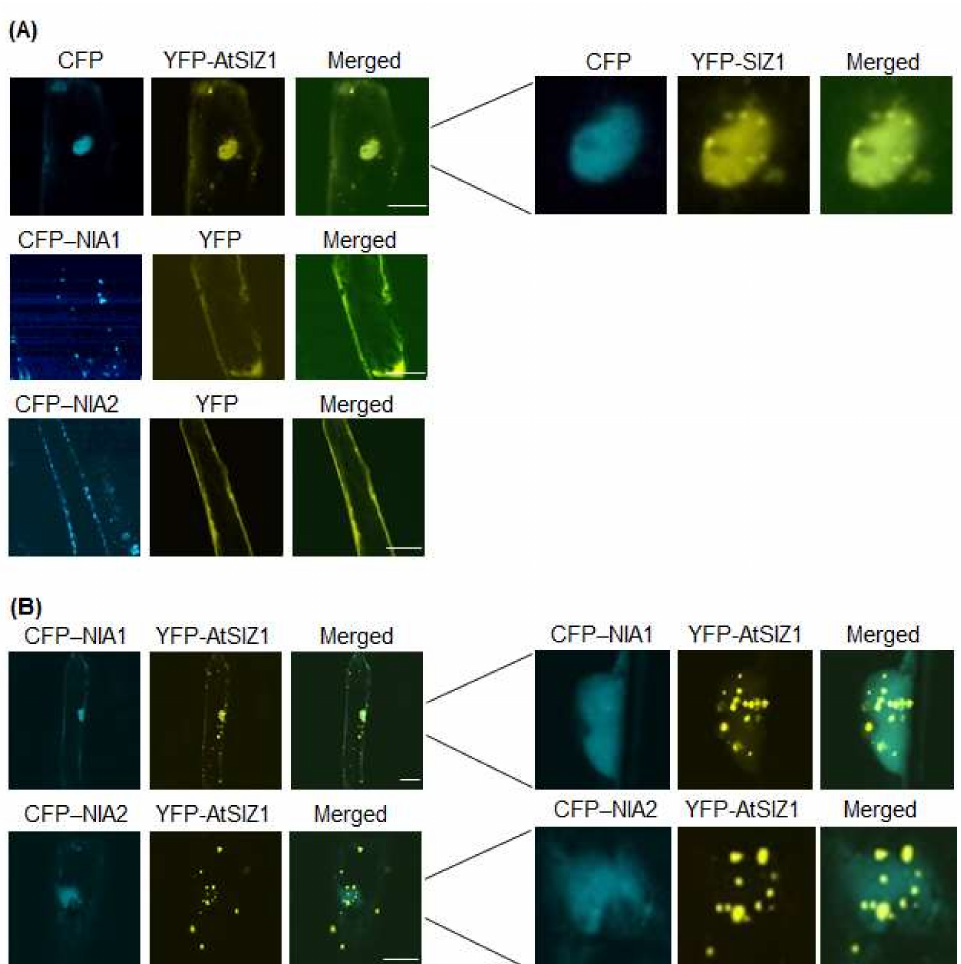
Figure 2. Effect of nitrate on subcellular localization of AtSIZ1 and NR proteins NIA1 and NIA2. Localization of NIA1, NIA2, and AtSIZ1 was investigated by particle bombardment of onion epidermal cells. Constructs harboring 35S-CFP-NIA1 , 35S-CFP-NIA2 , and 35S-YFP-AtSIZ1 were introduced into onion epidermal cells, either alone ( A ) or in combination ( B ), by particle bombardment. After incubation at 25 ◦ C in the dark for 16 h in 5 mM KNO 3 , the bombarded tissues were analyzed by confocal microscopy to visualize transient CRP or YFP expression. CFP-NIA1, CFP-NIA2, and YFP-AtSIZ1 refer to CFP and YFP fused to the C-terminus of NIA1, NIA2, and AtSIZ1, respectively. DIC, differential interference contrast. Bar, 50 µ